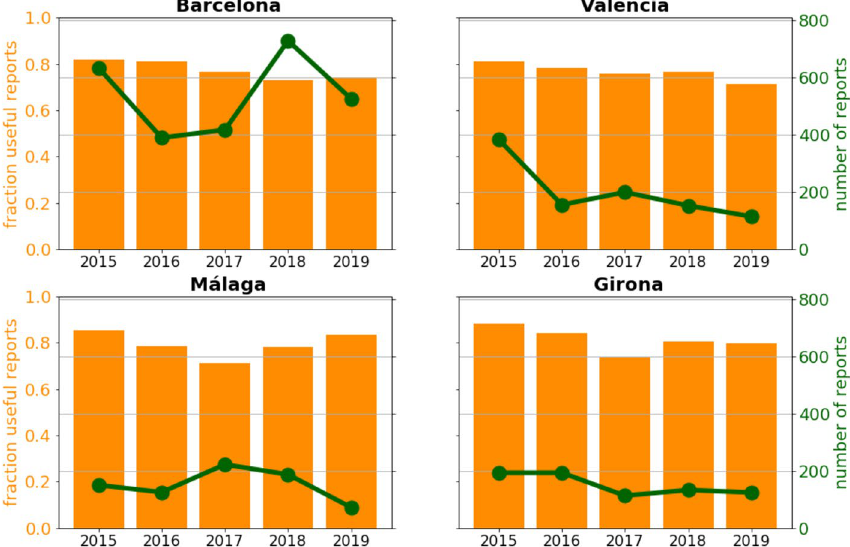
Figure 5. Number of submitted reports and the fraction of their ratio where the entomology expert annotator could tell if tiger mosquito was presented on the photo or not. The charts are shown for the four cities, where Mosquito Alert was the most